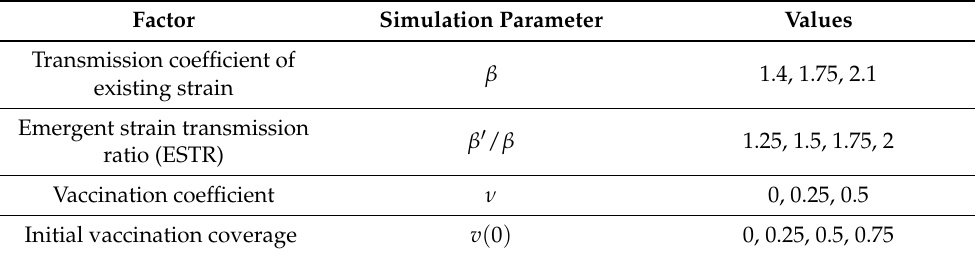
Table 1. The levels of each factor in the simulation-based experiment. Factor Simulation Parameter Values Transmission coefficient of β 1.4, 1.75, 2.1 existing strain Emergent strain transmission β (cid:48) / β 1.25, 1.5, 1.75, 2 ratio (ESTR) Vaccination coefficient ν 0, 0.25, 0.5 Initial vaccination coverage v ( 0 ) 0, 0.25, 0.5,